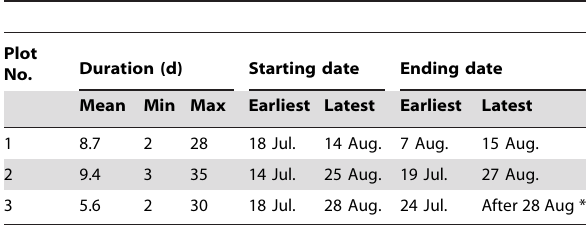
Table 1. Temporal variability of P. euphratica seed dispersal among